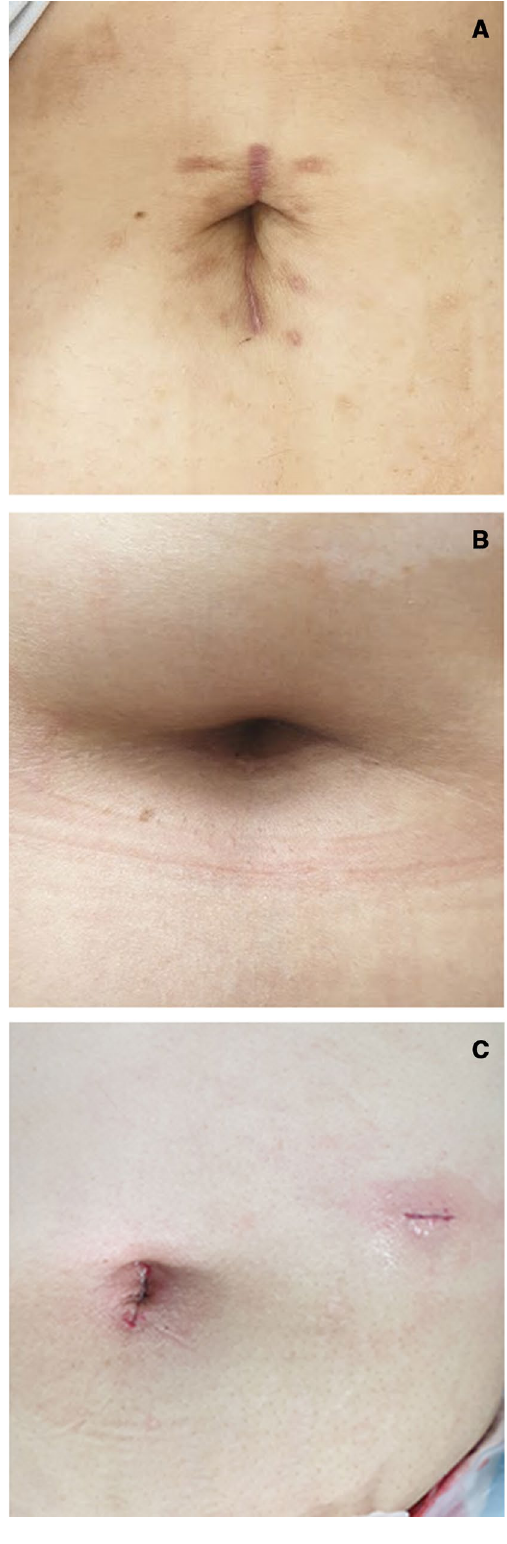
Figure 2. Postoperative wound after laparoscopic single-port and reduced-port sleeve gastrectomy. ( A ) Postoperative wound after laparoscopic single-port sleeve gastrectomy (2008–2018). ( B ) Postoperative wound after laparoscopic single-port sleeve gastrectomy, limited to the transumbilical level (2018–present). ( C ) Postoperative wound after laparoscopic reduced-port sleeve gastrectomy, with the main wound limited to the transumbilical level and an additional port